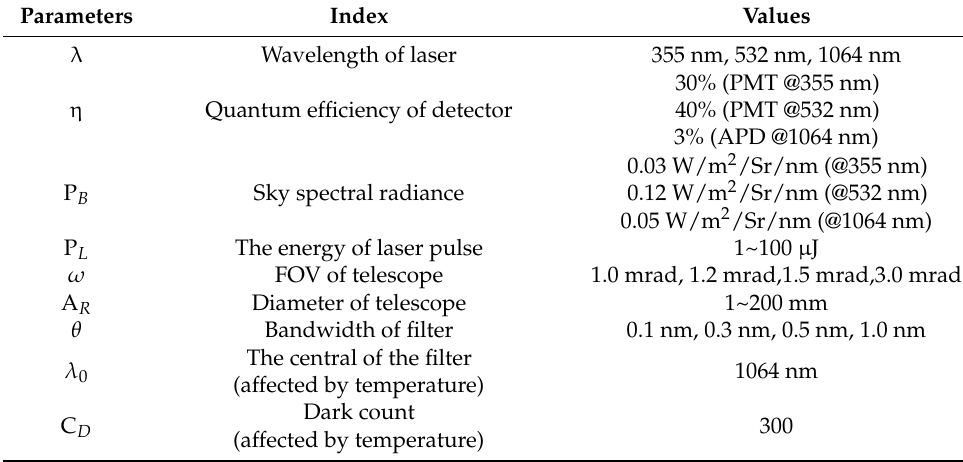
Table 1. Parameters to be optimized and Optimal values of mIRLidar.